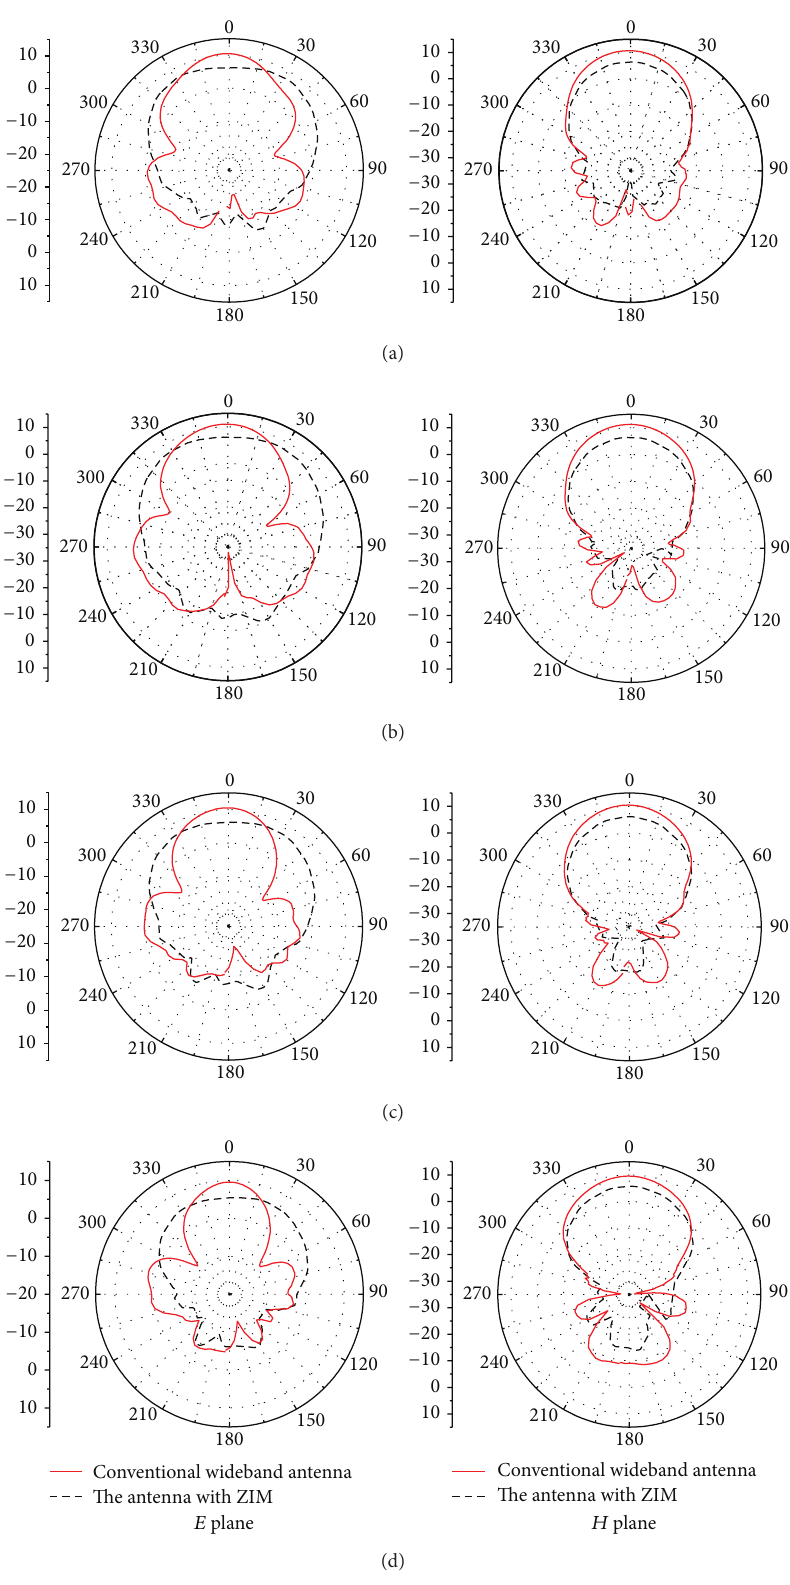
Figure 11: The measured radiation patterns for the conventional wideband antenna and the proposed antenna at the frequencies of (a) 10.15GHz, (b) 10.6GHz, (c) 10.8GHz, and (d)